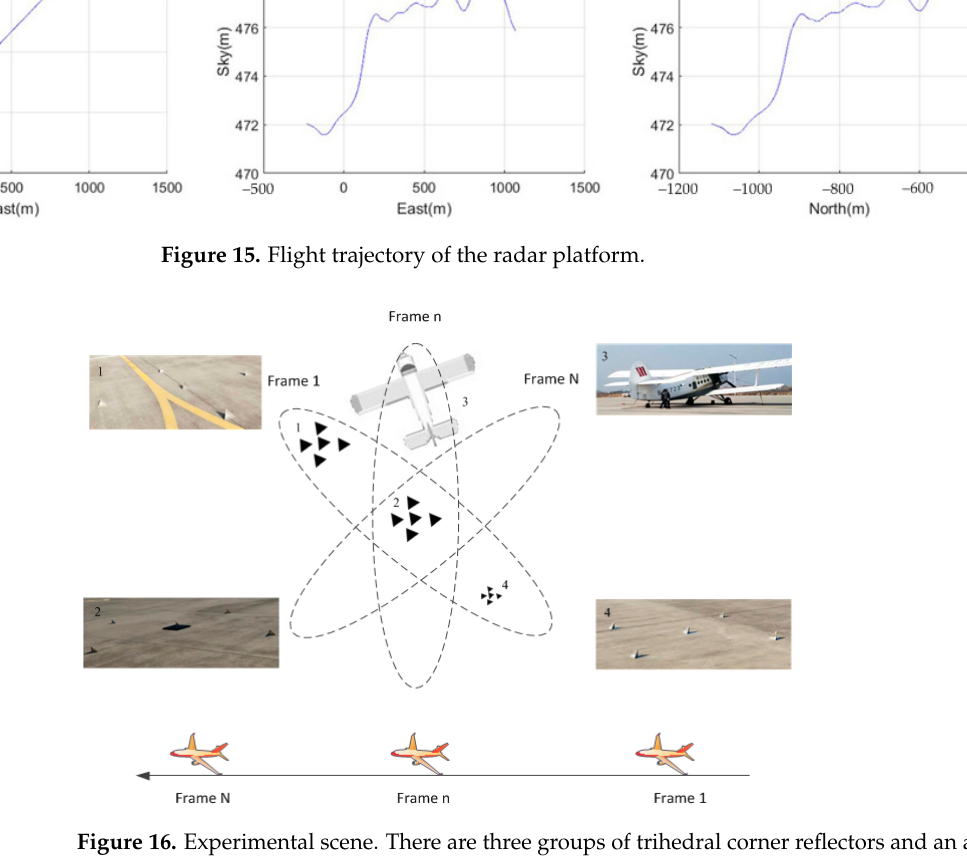
Figure 17. The imaging result of a single frame. ( a ) Original image corrupted by azimuth-variant phase error. ( b ) Imag- ing result refocused by MD. ( c ) Imaging result refocused by MD and PGA. ( d ) Imaging result focused by PGA directly.